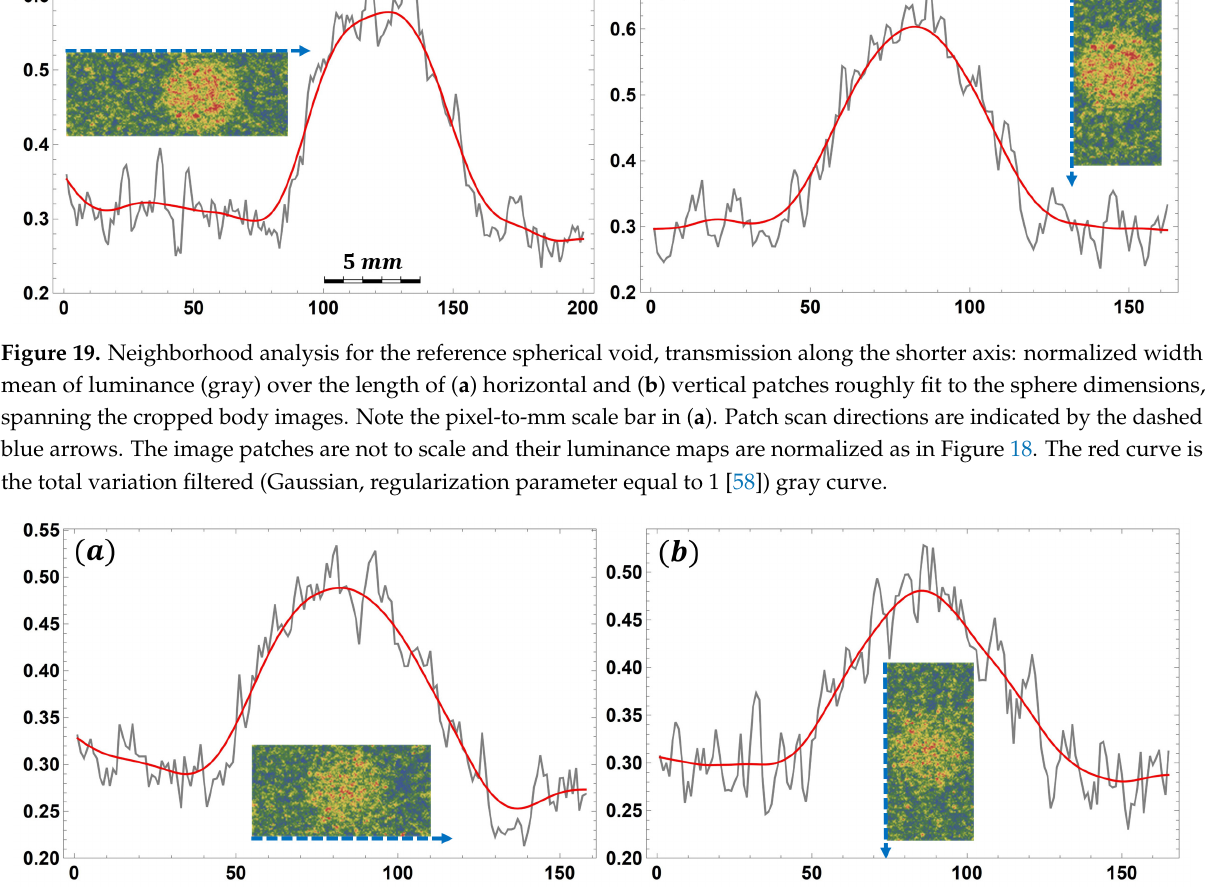
Figure 20. Neighborhood analysis for the reference spherical void, transmission along the longer axis: normalized width mean of luminance (gray) over the length of ( a ) horizontal and ( b ) vertical patches roughly fit to the sphere dimensions, spanning the cropped body